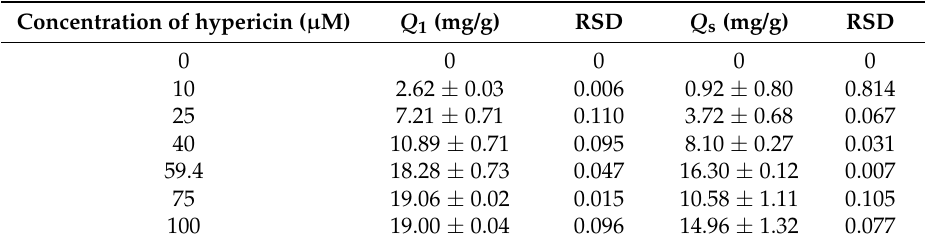
Table 4. The effect of the concentration of hypericin on Q s .